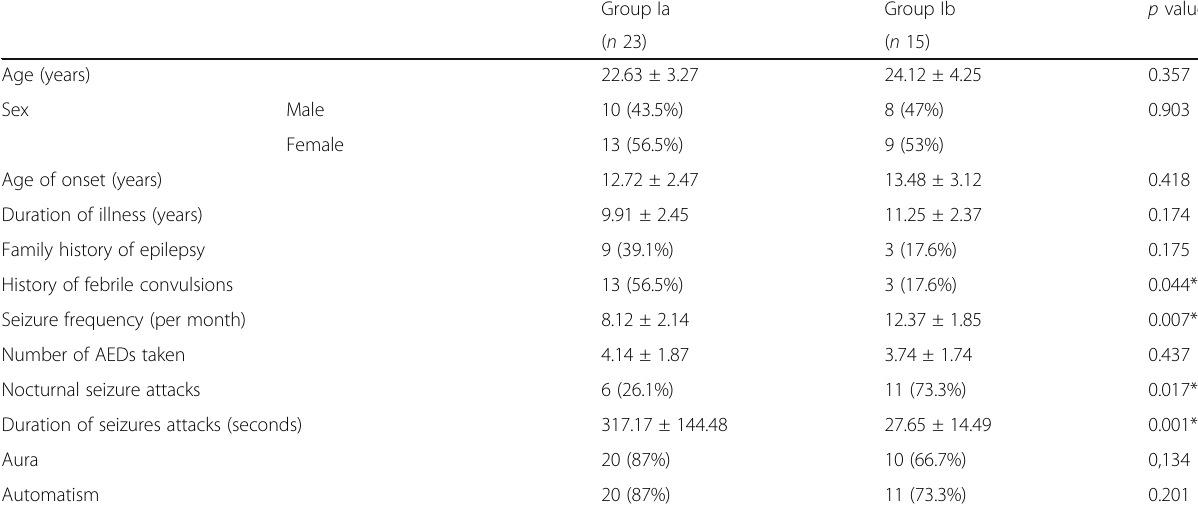
Table 2 Comparison between true drug-resistant epilepsy patients of temporal origin (group Ia) and frontal seizure onset zones (group